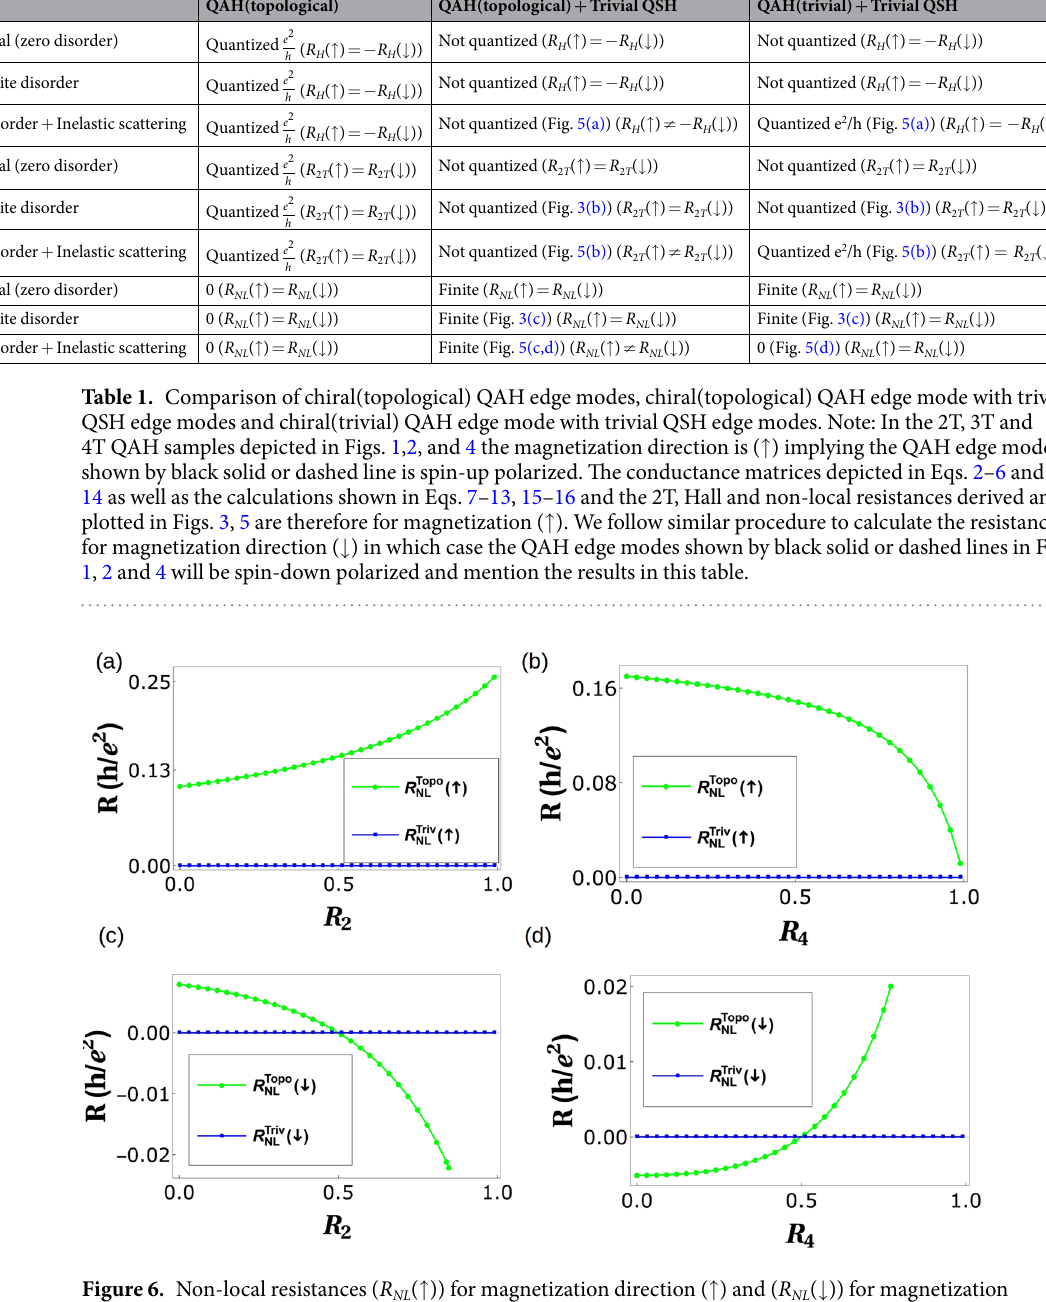
Effect of disorder and inelastic scattering. Herein we consider two of the contacts (1, 4) to be disordered. The electrons incoming from probe 6 with energy brated to the electrons coming from probe 4 to a new energy as shown below-